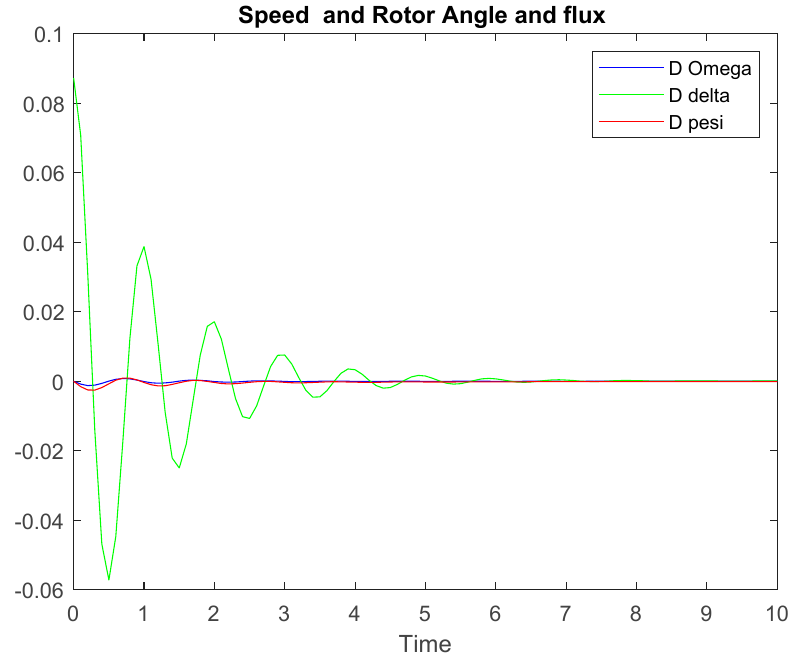
Figure 2. Diagram of the simulation of the rotor angle and speed changes up to 10 s.